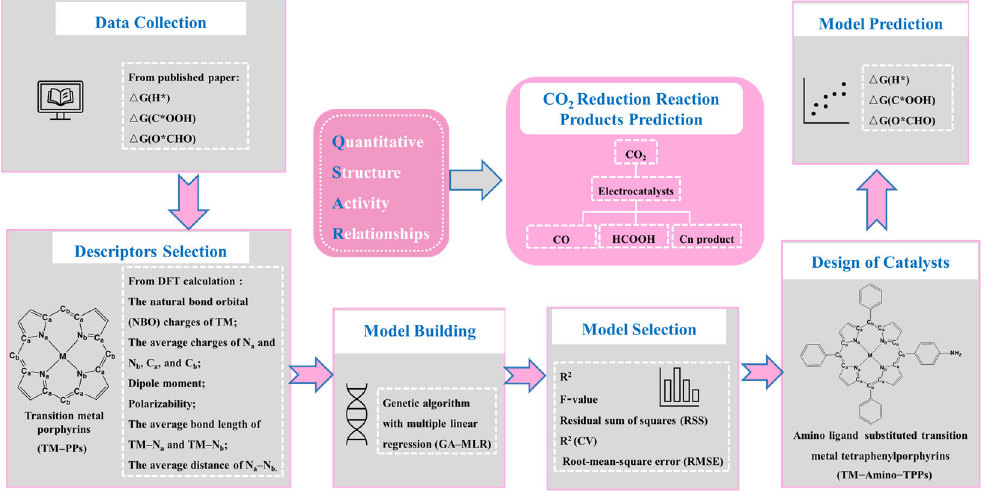
Figure 2. Workflow of the QSER–accelerated catalytic activity prediction of transition-metal–porphyrin complexes in this study.